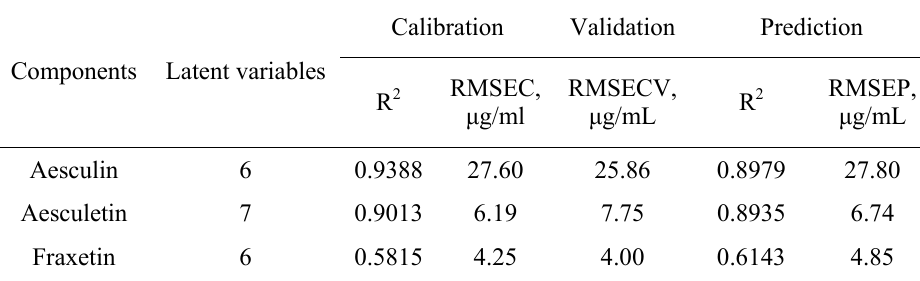
Table 4. The results of calibration and prediction of PLS model Calibration Validation